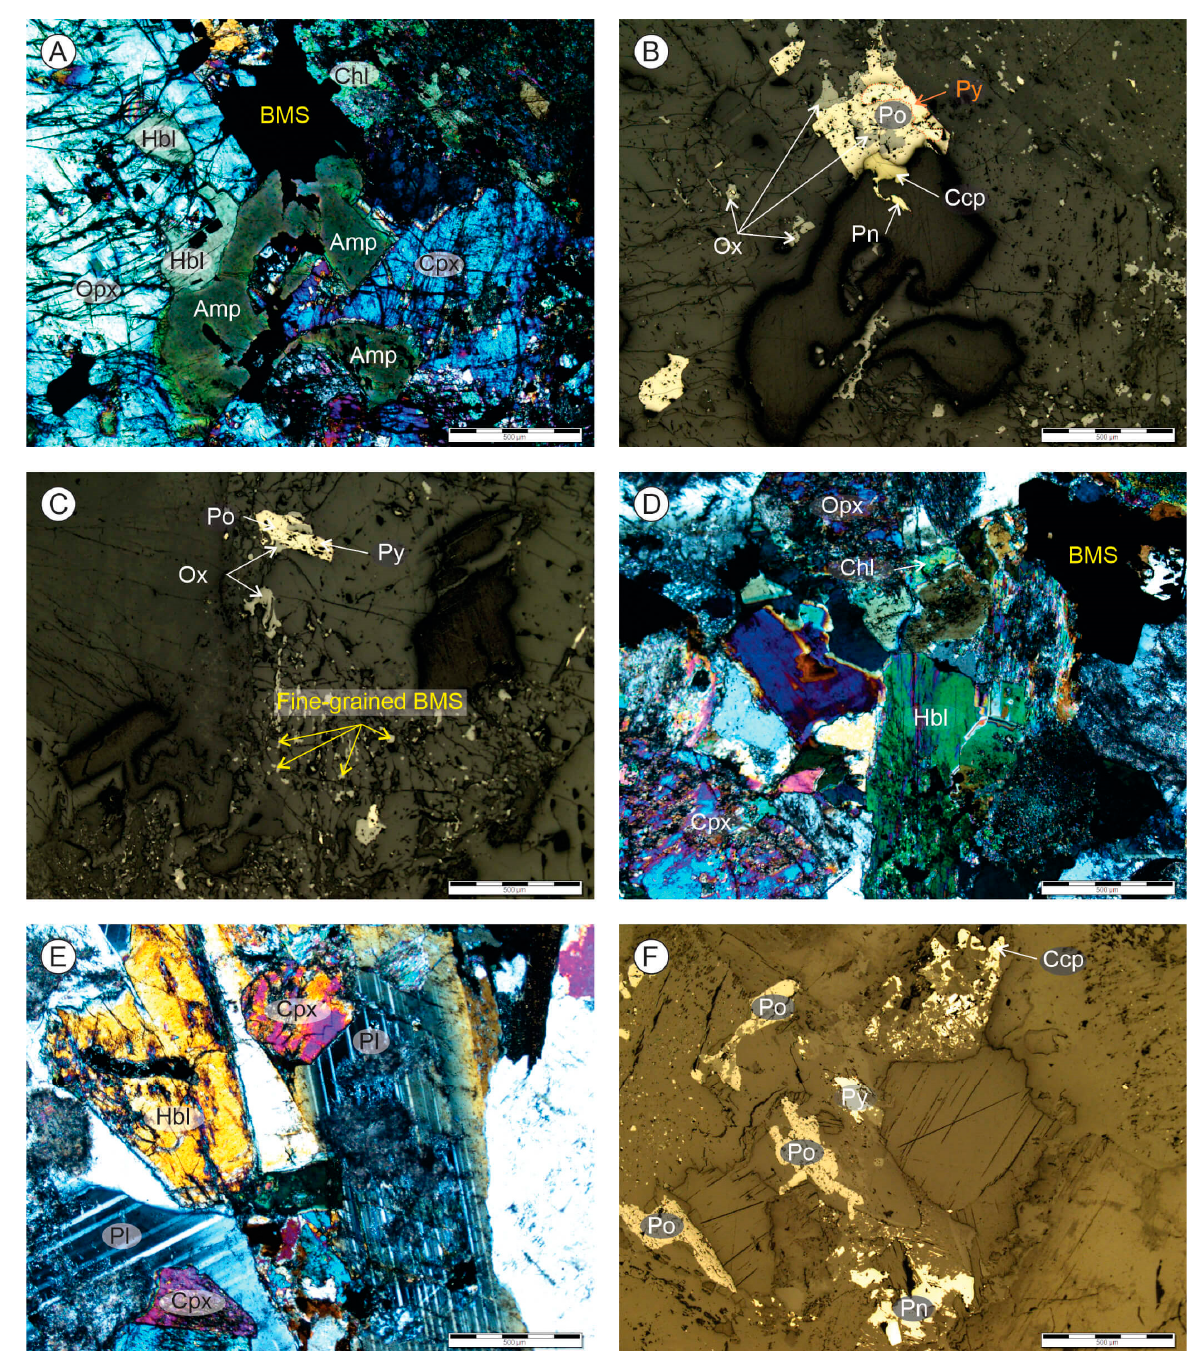
Figure 3. Photomicrographs of the high-grade and medium-grade disseminated sulfide ores showing various silicate ( A , D , E ) and sulfide ( B , C , F ) minerals. The scale bar at the bottom right corner of the images represents 500 µm. Refer to Figure 2 for explanation of the mineral abbreviations.